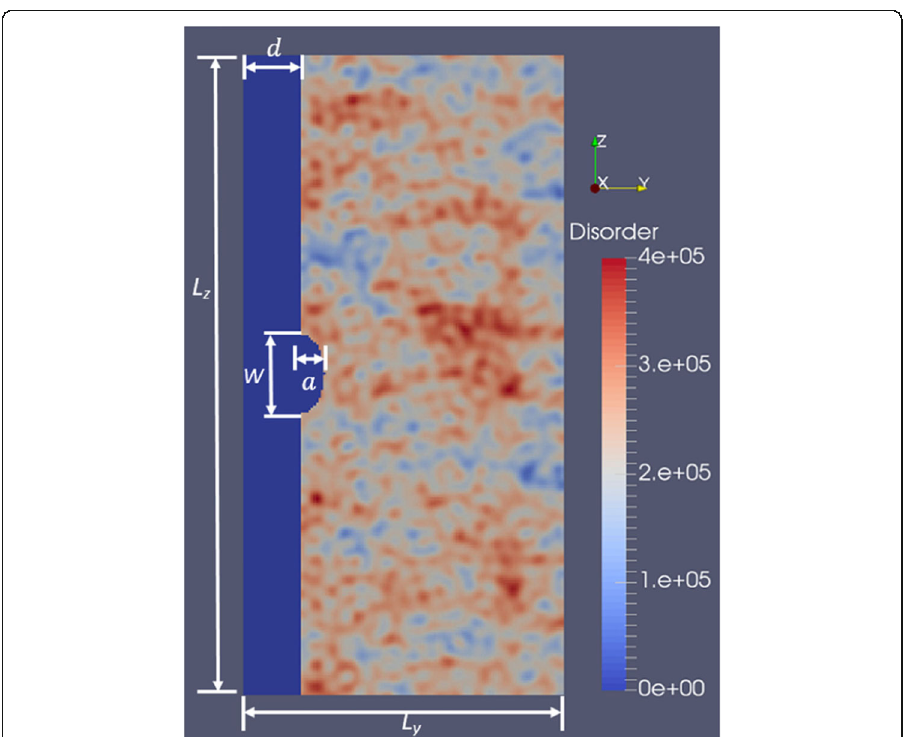
Fig. 1 Model Geometry & Disorder: The thickness of the sample, L x =8 μ m, the width of the sample L z =1.0 mm, the length of the sample, L y =0.5mm. The layer of air has thickness d=96 μ m, and the notch is an ellipse with constant major axis of a=64 μ m.. Here, the notch width W is 128 μ m, but it is varied throughout this work. Similarly, the disorder ratio in this example is R G =0.2